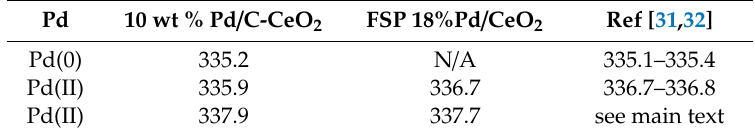
Figure 4. XPS data for Pd for ( a ) Pd/C-CeO 2 , and ( b ) FSP Pd/CeO 2 . Lines marked Pd(0), Pd(II) and Pd(II) are assigned respectively to metallic Pd, sub-stoichiometric PdO and super-stoichiometric PdO. XPS data for Ce for ( c ) Pd/C-CeO 2 , and ( d ) FSP Pd/CeO 2 . To aid comparison with previous work, the commonly used nomenclature of Burroughs et al. [30] was adopted in ( c ). Table 1. Normalized Pd 3d 5/2 binding energies for the Pd/C-CeO 2 and FSP 18%Pd/CeO 2 samples.